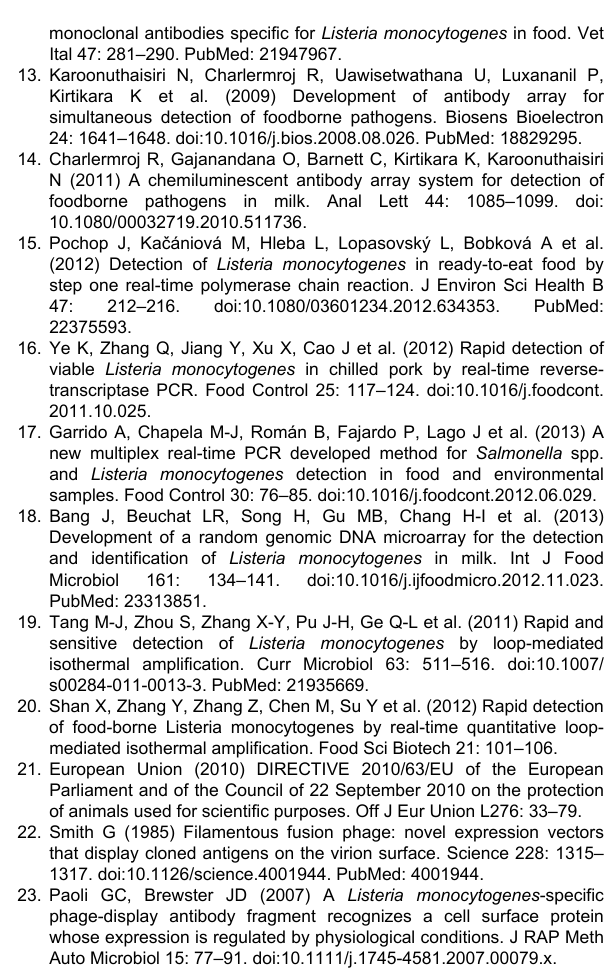
Figure S2. Multiple sequence alignment for DNA sequences from round 5 generated using ClustalW2 2.1 (http://